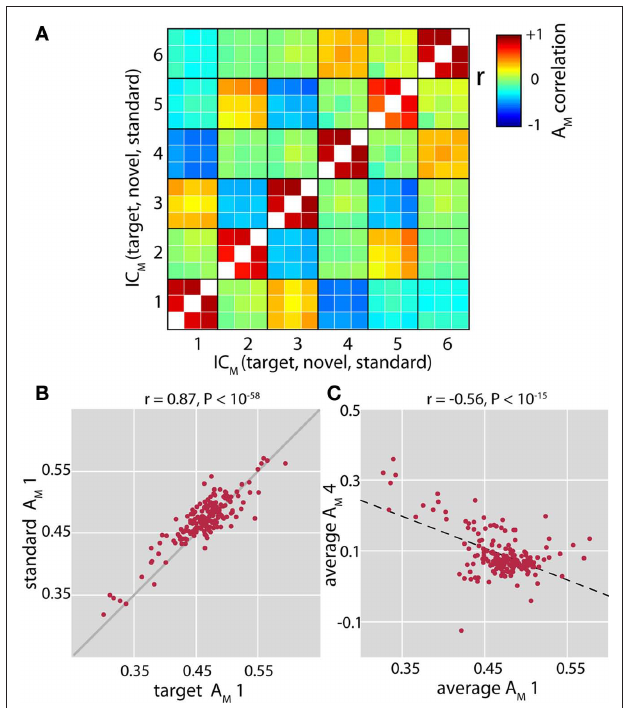
FiGuRE 4 | Relationships between cross-frequency modulation loading parameters. (A) Full correlation matrix between loading parameters (A ) for each cfM component and each condition (target, novel M and standard stimuli). In general, component weights are well correlated between conditions (values along the diagonal). (B) Example of correlation between loading parameters of target tones and standard tones for IC Solid gray line indicates unity. (C) Negative correlation between the loading parameters of IC 1 and IC 4. Here, the loading parameters have been M M averaged over condition. Dashed black line shows the least-squares linear fit to